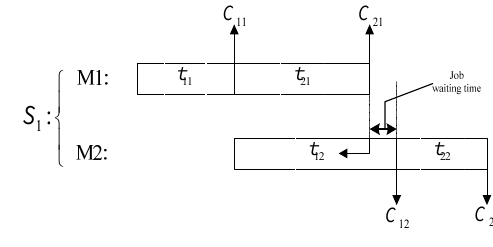
Fig. 1. First scenario and the second job waiting time Fig. 2. Second scenario and creation of waiting time in